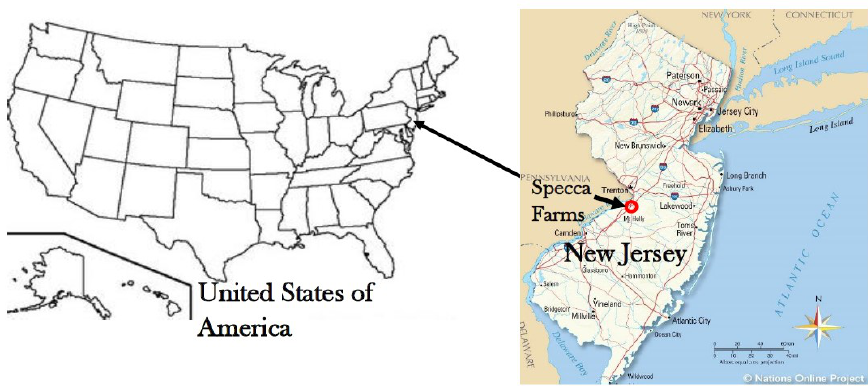
Figure 1. Location of Specca Farm Pick-Your-Own in New Jersey, United States (Map Source: https://www.nationsonline.org/oneworld/map/USA/new_jersey_map.htm (accessed on 15 March 2022).